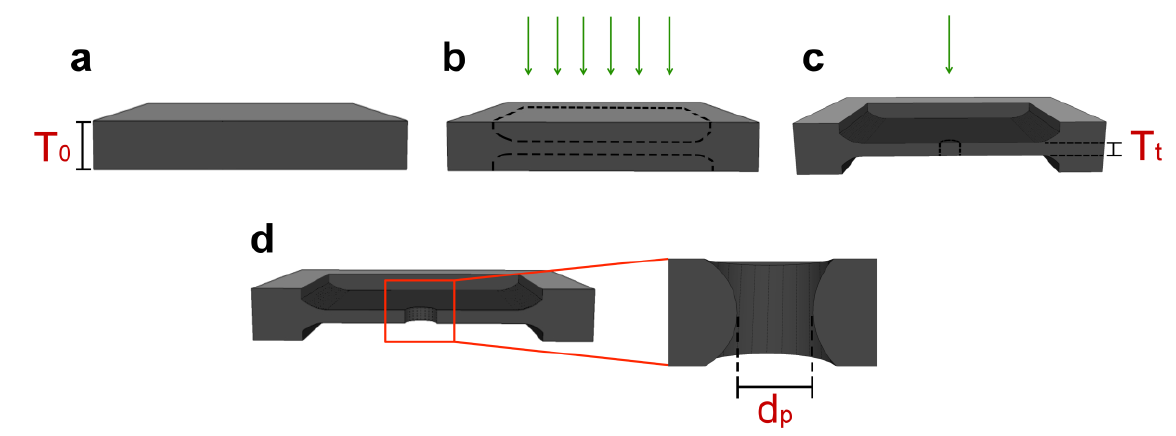
Figure 1. Schematic representation of ultrathin nanopore fabrication process. ( a ) Cross-section of a free-standing SiN membrane with initial thickness T (green arrows) of a square region inside which material is controllably removed from both sides of the membrane simultaneously, resulting in ( c ) a final thickness T single spot within the thinned region results in ( d ) a nanopore with diameter d